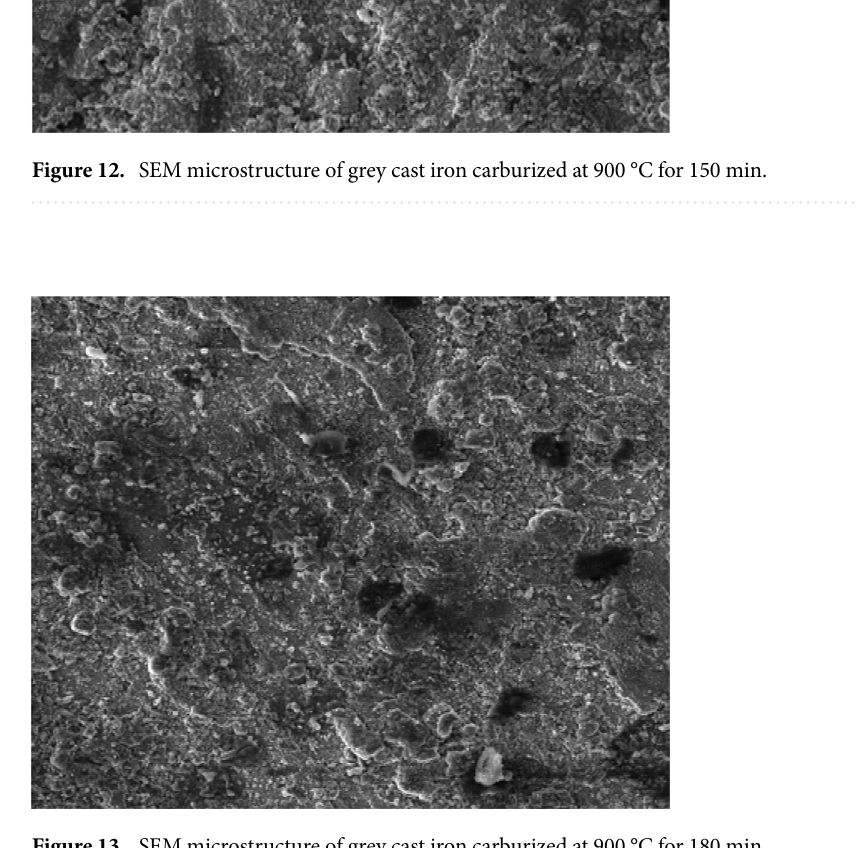
Figure 13. SEM microstructure of grey cast iron carburized at 900 °C for 180